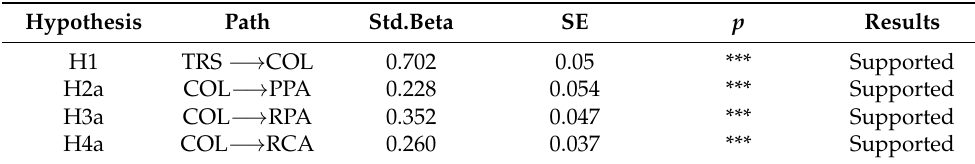
Table 7. Path relationships of the direct